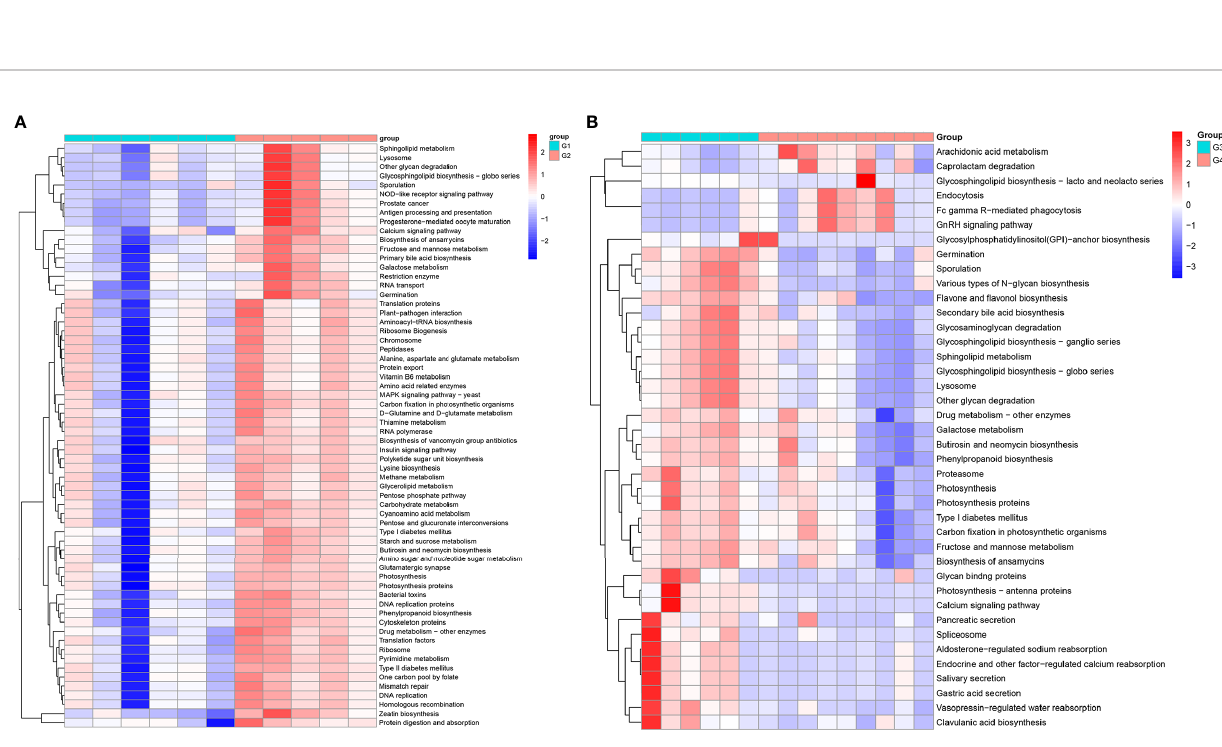
FIGURE 10 | The Kyoto Encyclopedia of Genes and Genomes(KEGG) pathway analysis between smokers and non-smokers. (A) Differential pathways in healthy men, (B) differential pathways in men with